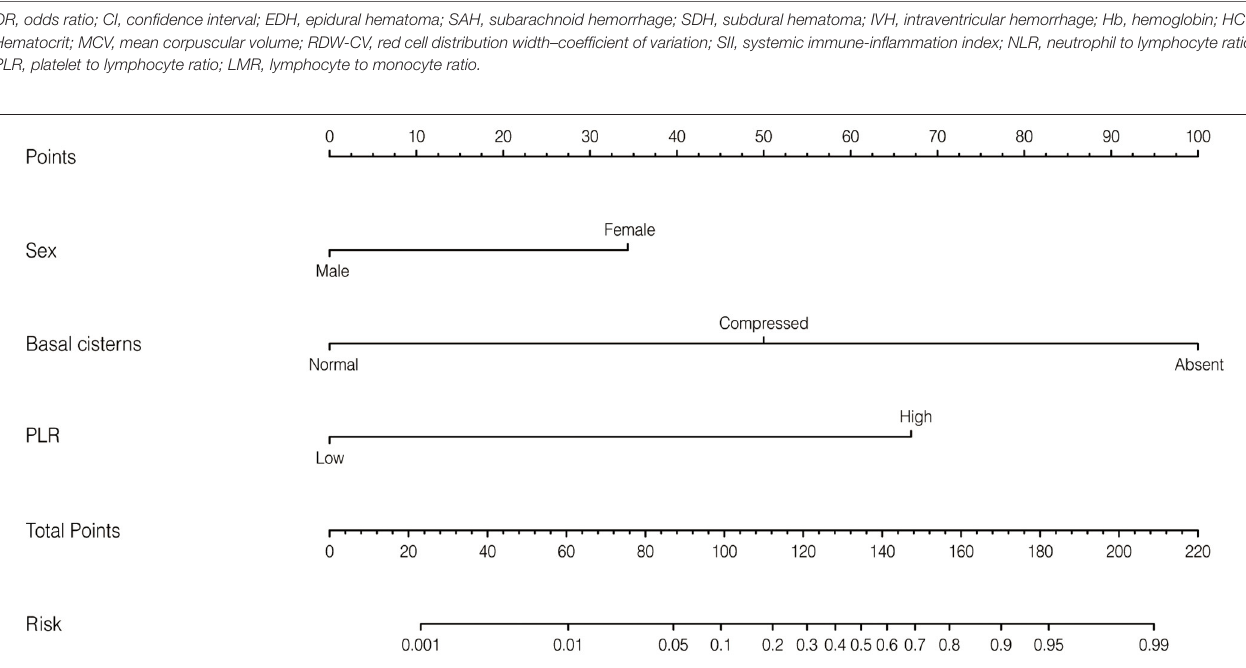
findings is still unclear and has not been extensively explored.